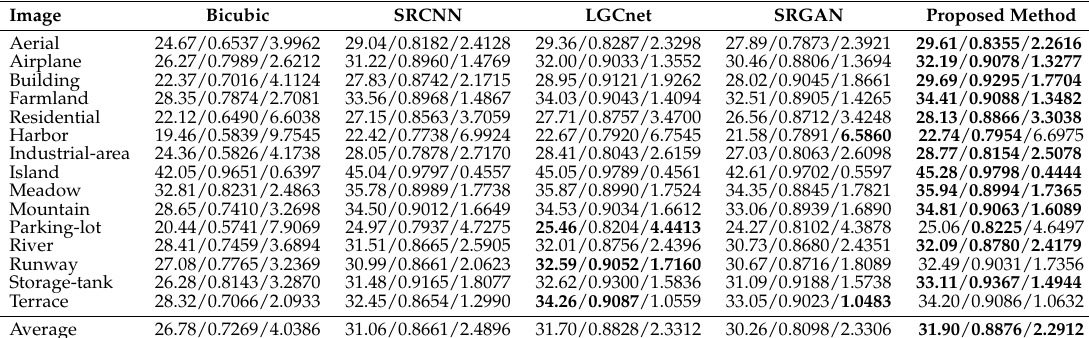
Table 4. PSNR/SSIM/ERGAS Results for Test Images (Scale Factor = 3, Noise = 0).